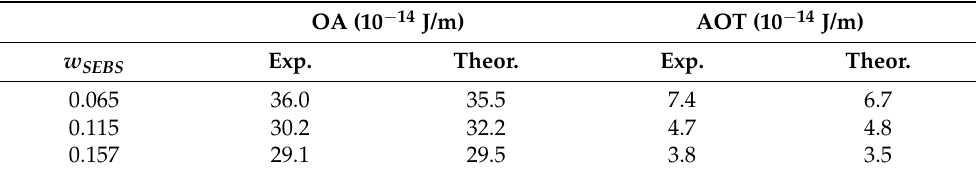
Table 2. Comparison between experimentally acquired slopes (see Figure 4c,d) and theoretically calculated values using k c = 0.39 Å − 1 . OA (10 − 14 J/m) AOT (10 − 14 J/m) w SEBS Exp. Theor.